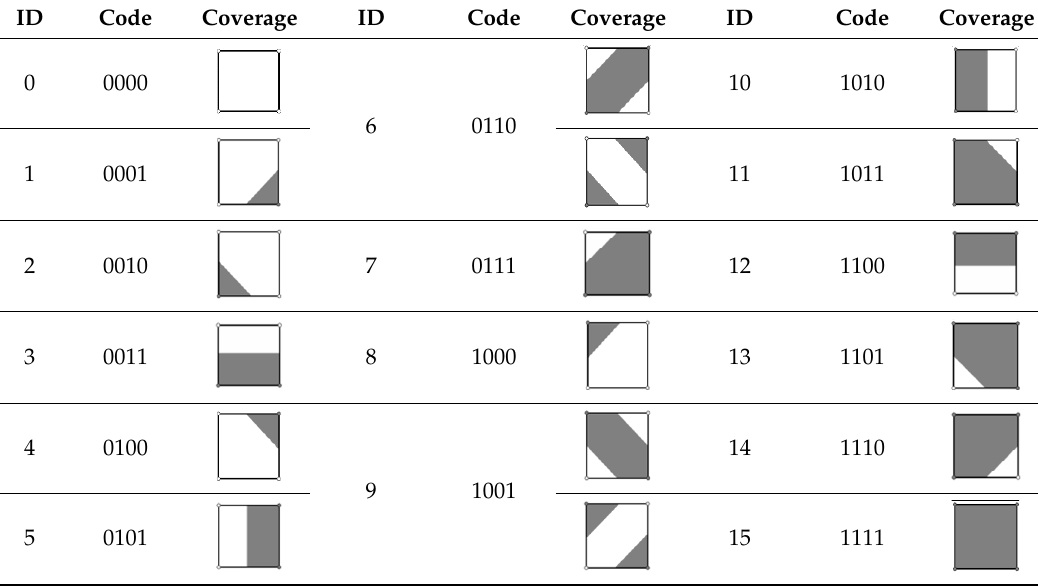
Table 1. Codes of grids.